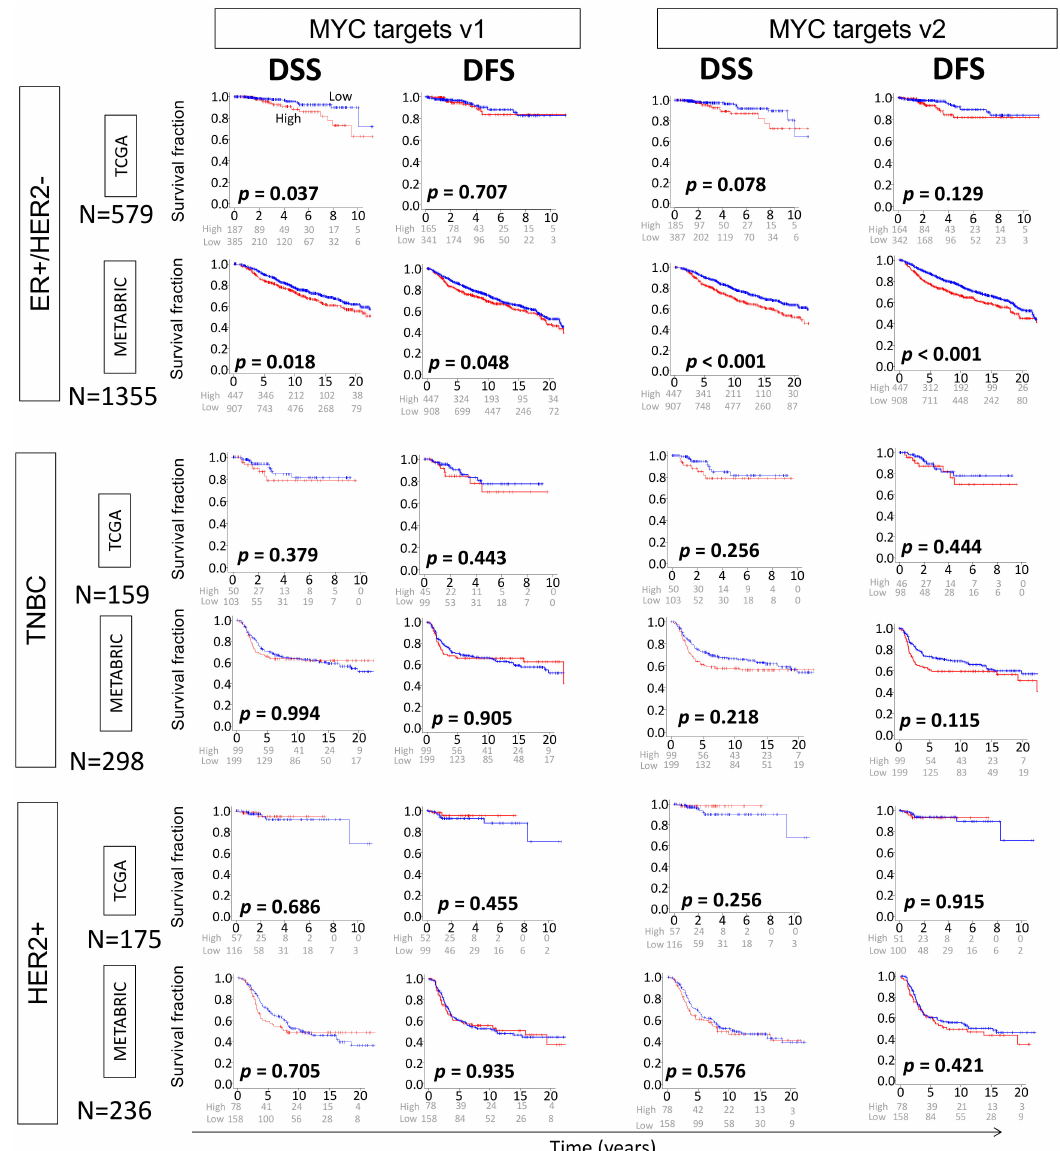
Figure 3. Association of the MYC score and clinical outcomes in the TCGA and METABRIC cohorts. Kaplan–Meier plots with log-rank test p -values showing survival di ff erence among high and low MYC target v1 and MYC target v2 scores in the ER-positive / HER2-negative, TNBC and HER2-positive subtypes. DFS, disease-free survival; DSS, disease-specific